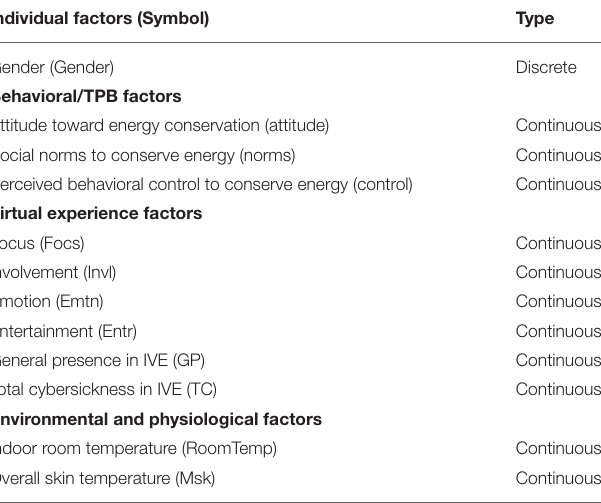
TABLE 1 | Key treatment factors along with their abbreviations and data types. Individual factors